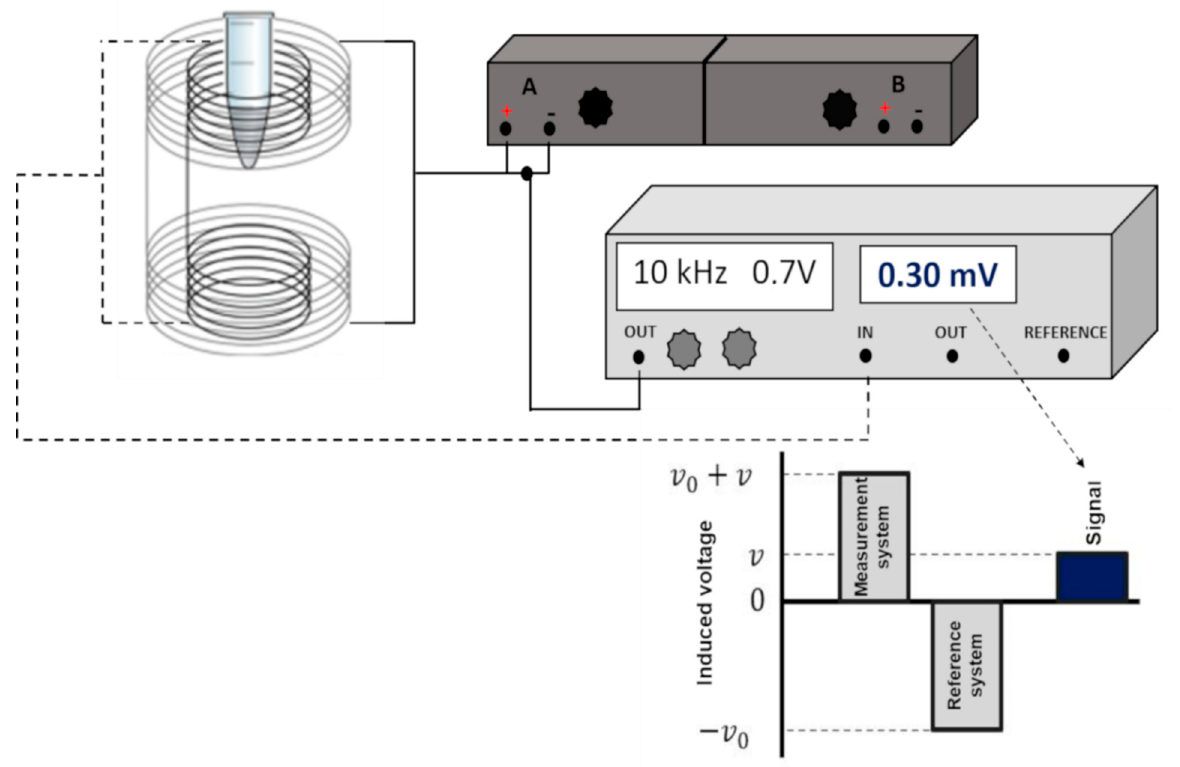
Figure 1. Schematic diagram of ACB setup used for MNP measurements. Through a phase-sensitive amplifier (lock-in—Stanford Research Systems SR830) (light grey), an electrical signal of 0.7 V at a frequency of 10 kHz is generated and is amplified by power amplifiers ( − 3 dB) (dark gray), in which the resulting current is applied to the excitation coils.